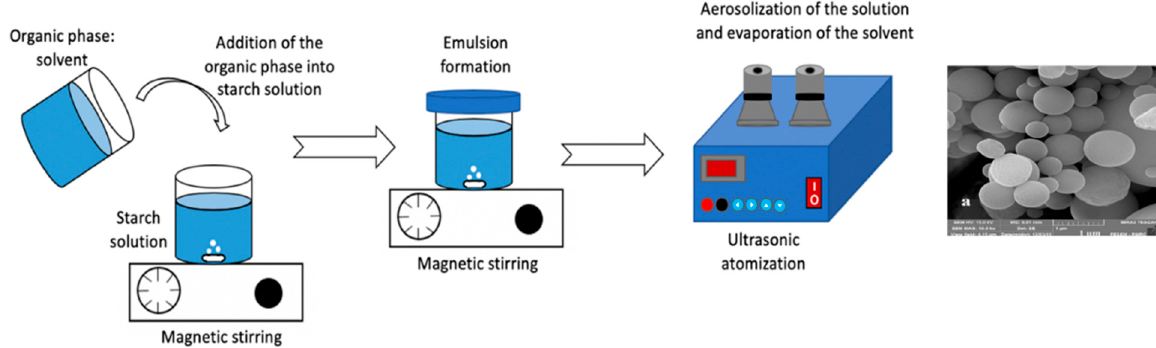
Figure 9. Synthesis of SNPs through ultrasonic atomization method and FE-SEM micrograph of SNPs. Reprinted from [68] with permission from Elsevier. Copyright (2019).